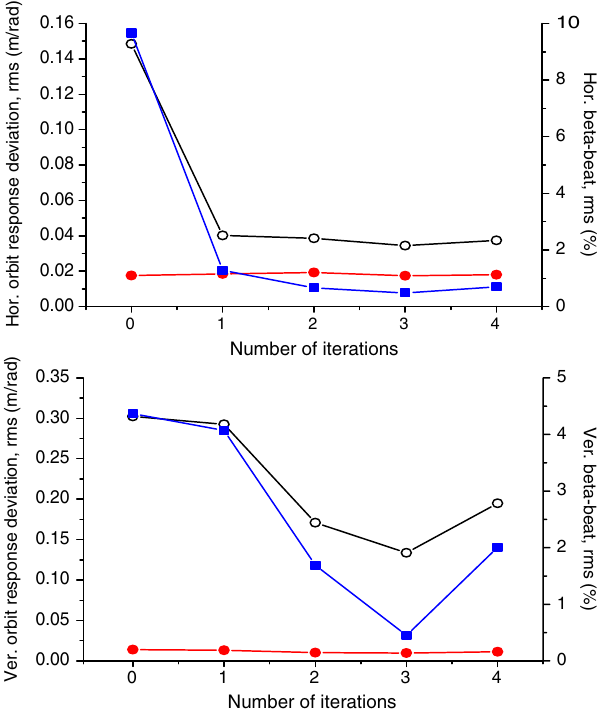
FIG. 3. Deviations of orbit response and reconstructed beta- beat vs number of correction iterations. The deviation of orbit response is computed in two ways: the deviations with respect to the ideal orbit response after LOCO fitting with quadrupole corrections excluded (black), and included (red). The left axis marks for the deviation of orbit response while the right axis indicates the beta-beat (blue) reconstructed by adding the fitted quadrupole corrections to the ideal optics model.